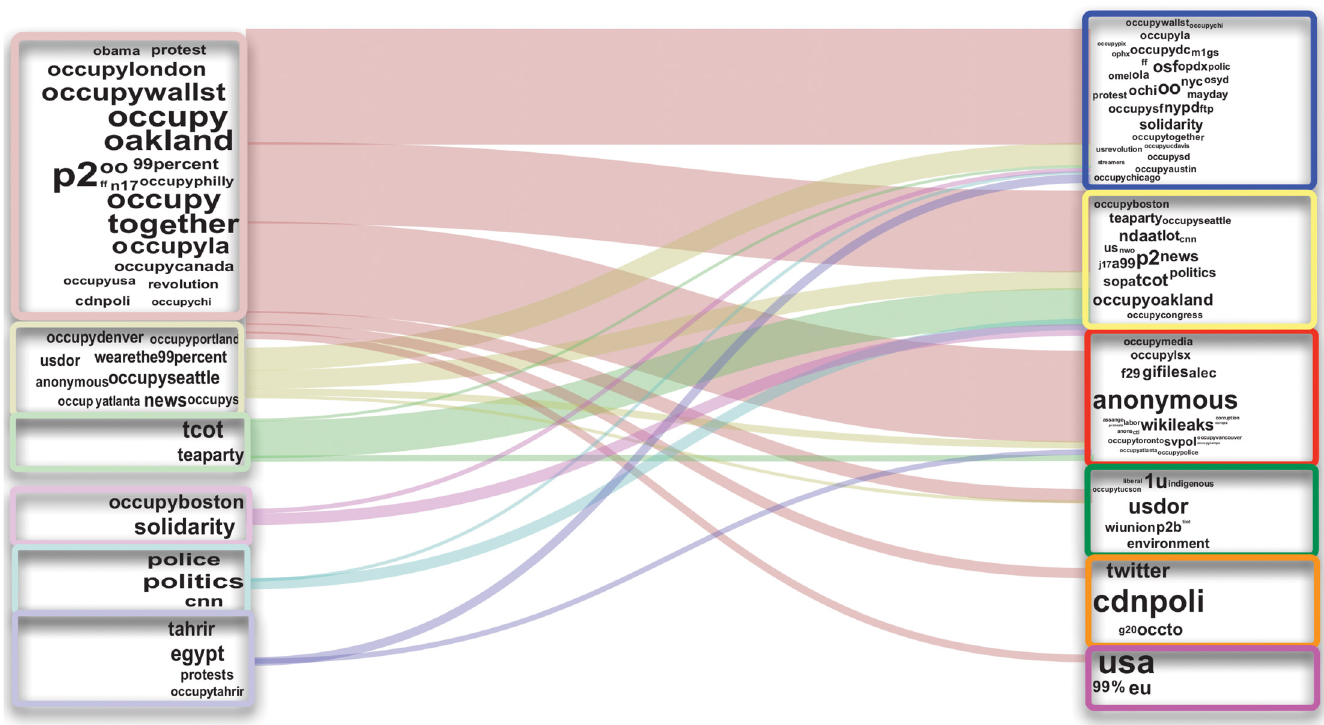
Fig 7. Evolution of the users ’ participation to the semantic communities during Occupy Wall Street Movement. On the left end we have the hashtags used in the communities in the first phase of the movement; on the right end we have the same at the end of the movement. Connecting lines represent the flows of users whose interests in the discussion have changed during the period of the movement as represented from the different types of hashtags they use (i.e. users using hashtags in community i at the beginning and in community j at the